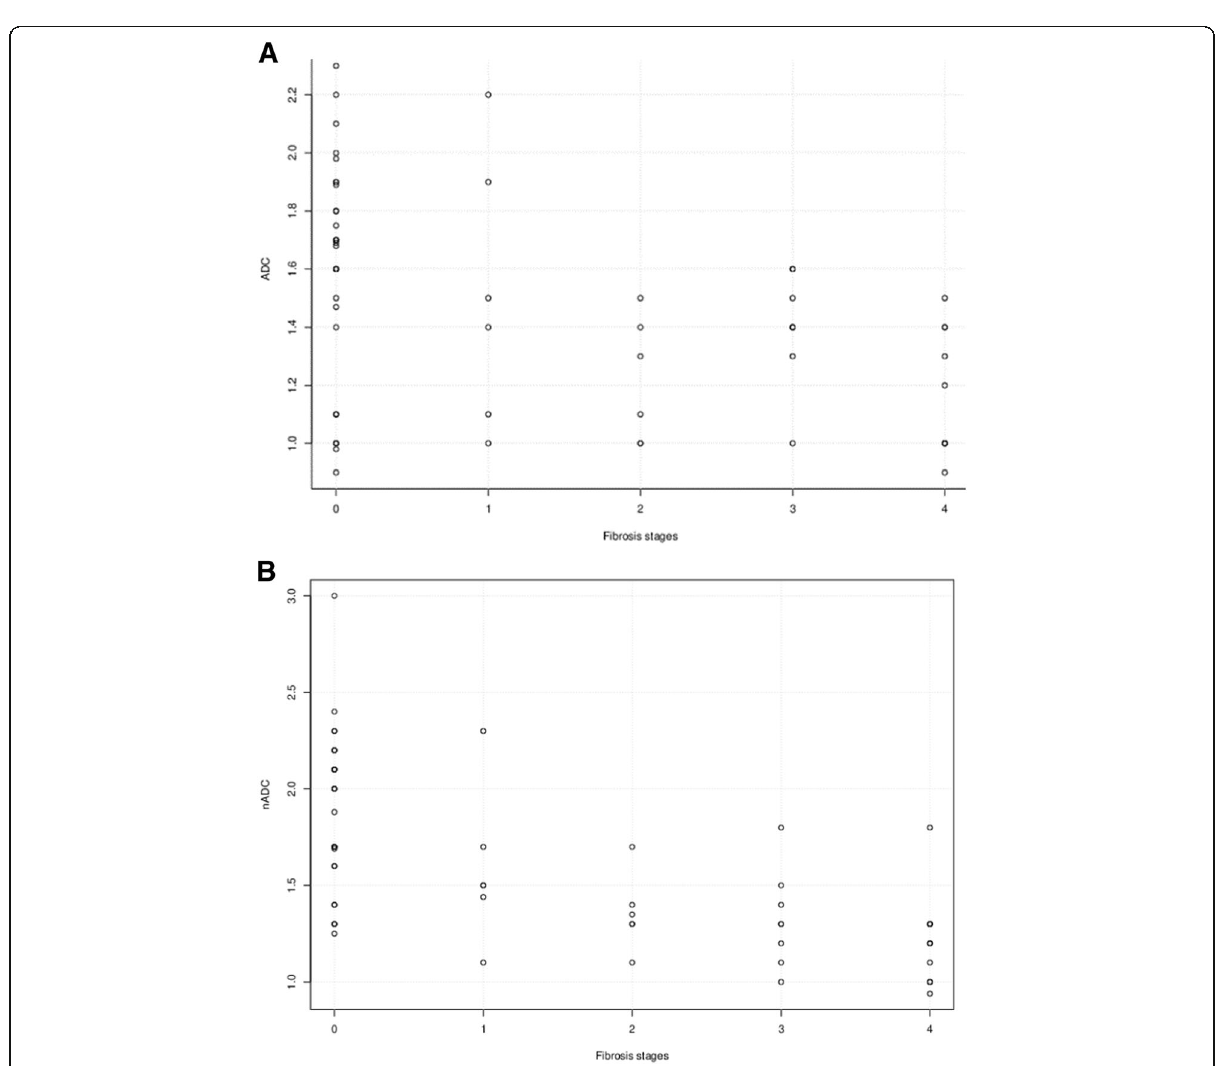
Fig. 1 a , b shows negative correlation between mean liver ADC of control group and different fibrosis stages groups. (Spearman ’ s rank correlation coefficient rs = -0.6 ,95% CI: − 0.446 – 0.015, p = 0.0374), also negative correlation between nADC of control group and different liver fibrosis stages groups. (Spearman ’ s rank correlation coefficient rs = - 0.82 ,95% CI: − 0.634 – 0.285, p